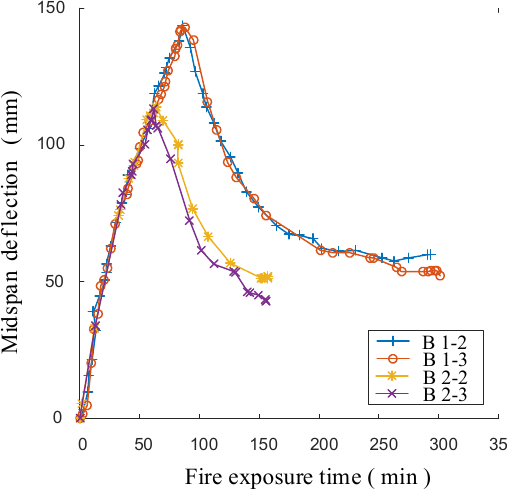
Figure 25. The middle of deflection responses of slabs at heating and cooling stages [113].